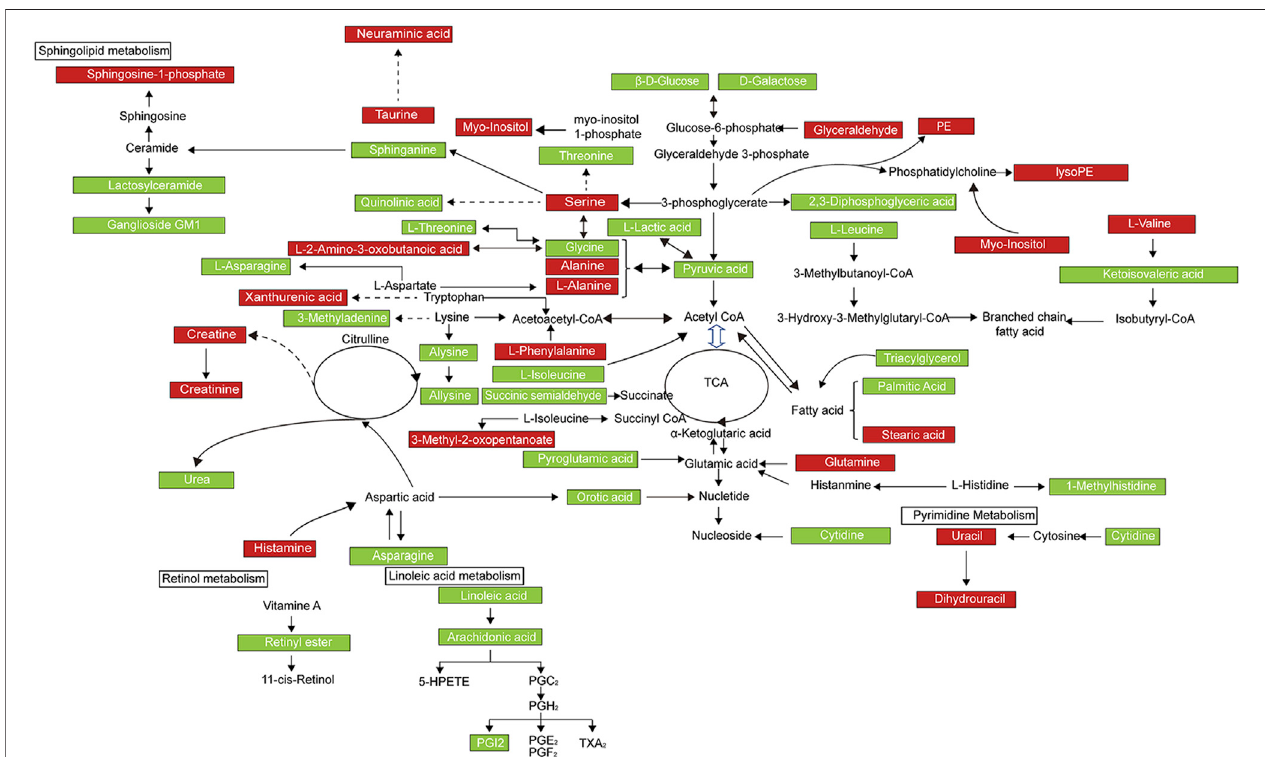
FIGURE 5 | Metabolic network of the signi fi cantly changed endogenous metabolites in both serum and urine. Compared with the model group, elevated metabolites in the EDA group were represented by red, and the reduced metabolites were represented by green.